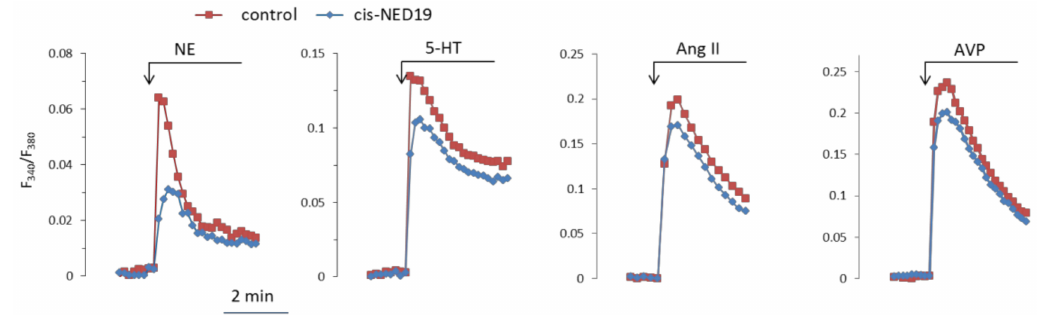
Figure 3. The kinetics of [Ca 2 + ] i changes in response to NE, 5-HT, Ang II, or AVP in rat aorta SMCs in the absence and presence of cis-NED 19. Concentration of cis -NED 19 was 5 µ M in the case of NE application and 25 µ M in other cases. Concentration of NE was 100 µ M, 5-HT 10 µ M, Ang II, and AVP 0.1 µ M. The representative curves from one of four or more independent measurements are shown. Quantitative data are presented in Figure 4.